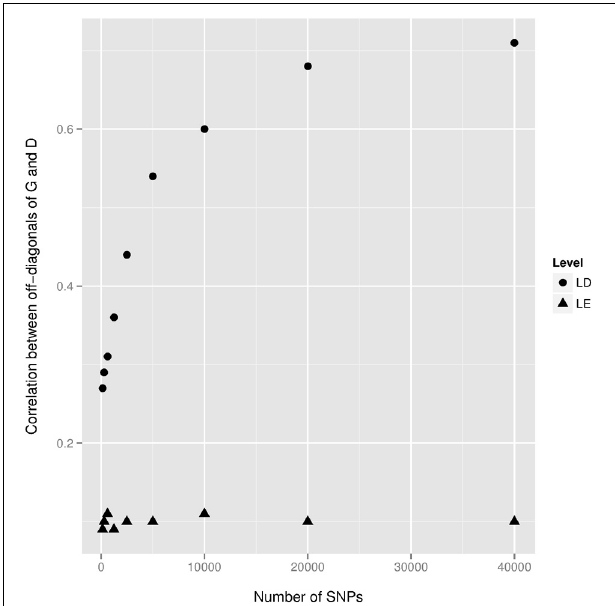
FIGURE 3 | Correlations between off-diagonal elements of the additive genomic relationship matrix G and of the dominance relationship matrix D as a function of the number of SNPs. Genotypes were both randomly sampled from the present study (Level = LD) and via a computer simulation locus by locus (Level = LE) with an average minor allele frequency equal to 0.35. The averages of the r 2 linkage disequilibrium (LD) statistic between adjacent markers were 0.18 and 0.008 for the real and simulated datasets, respectively.